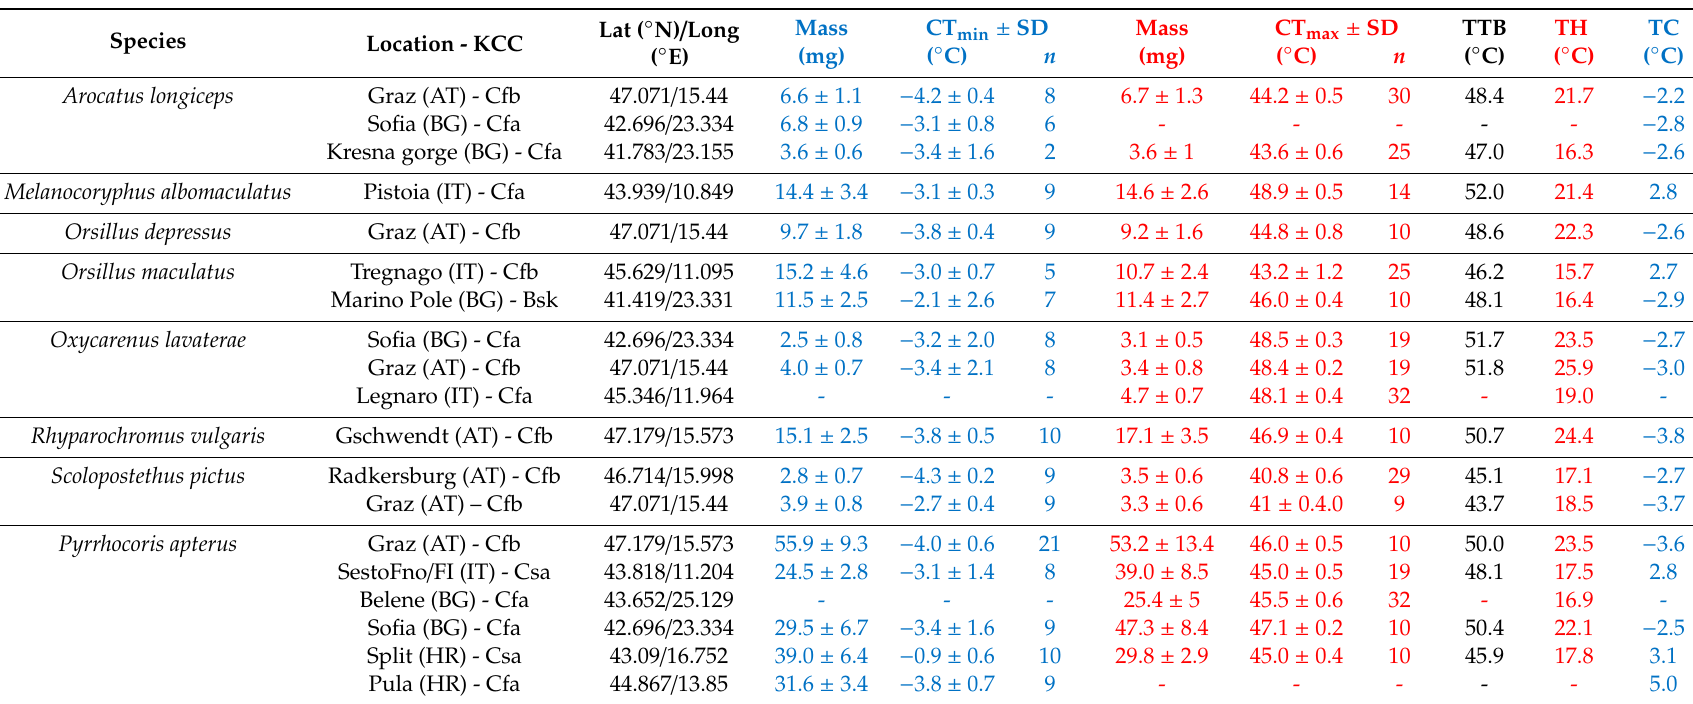
Table 2. Species, sample location and Köppen–Geiger climate classification (KCC), mean body mass with SD, critical thermal minima and maxima (CT min , CT max ) with SD, thermal tolerance breadth (TTB), and heat and cold tolerance (TH, TC) of the true bugs assessed.